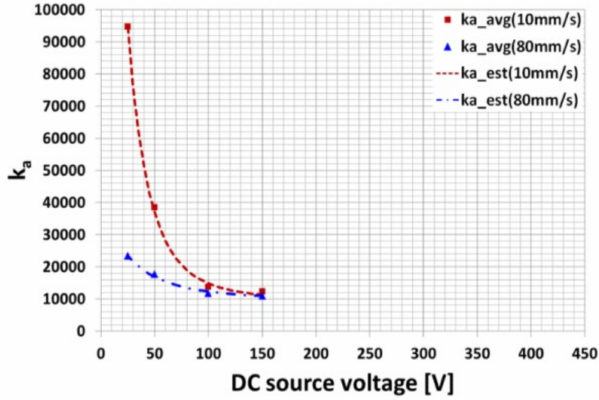
Figure 6. Average experimental value and estimation curve of arc empirical constant k a according to source voltage (Source voltage < 200 V).